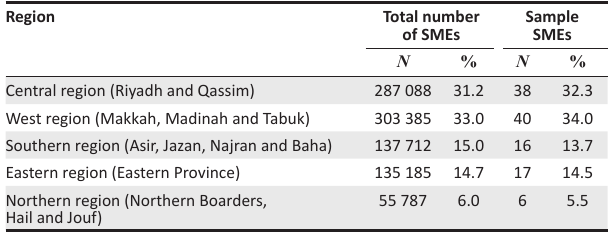
TABLE 2: Convergent validity test.